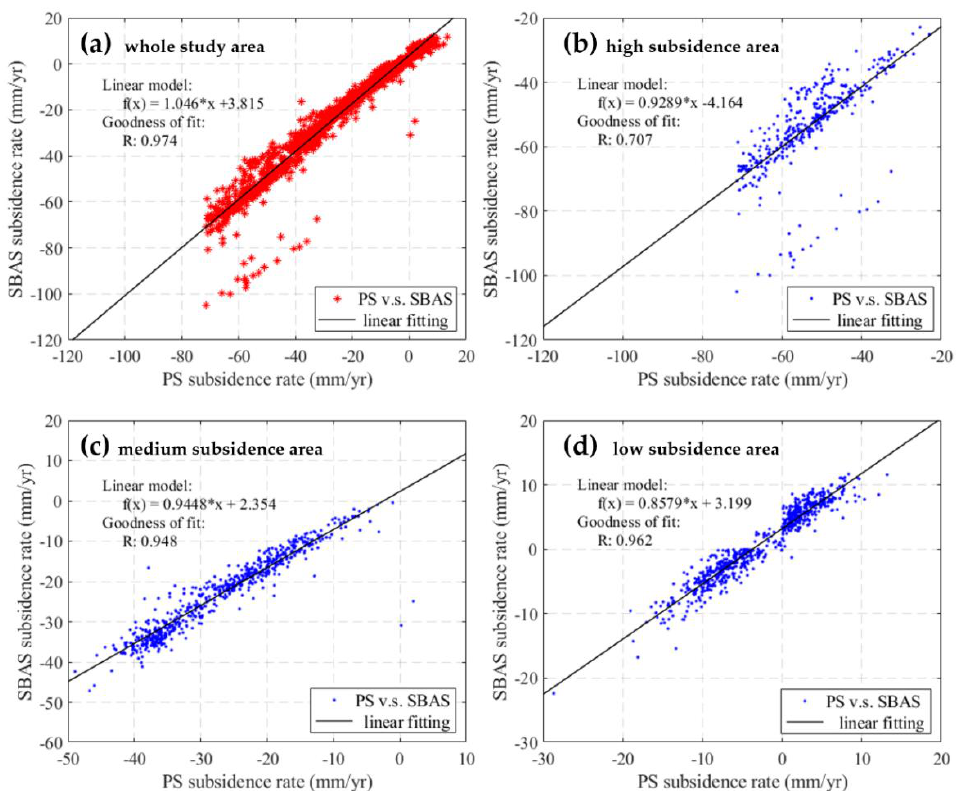
Figure 8. Regression analysis between surface subsidence rates gained from PS and SBAS in ( a ) the whole study area; ( b ) the high subsidence area; ( c ) the medium subsidence area; and ( d ) the low subsidence area.